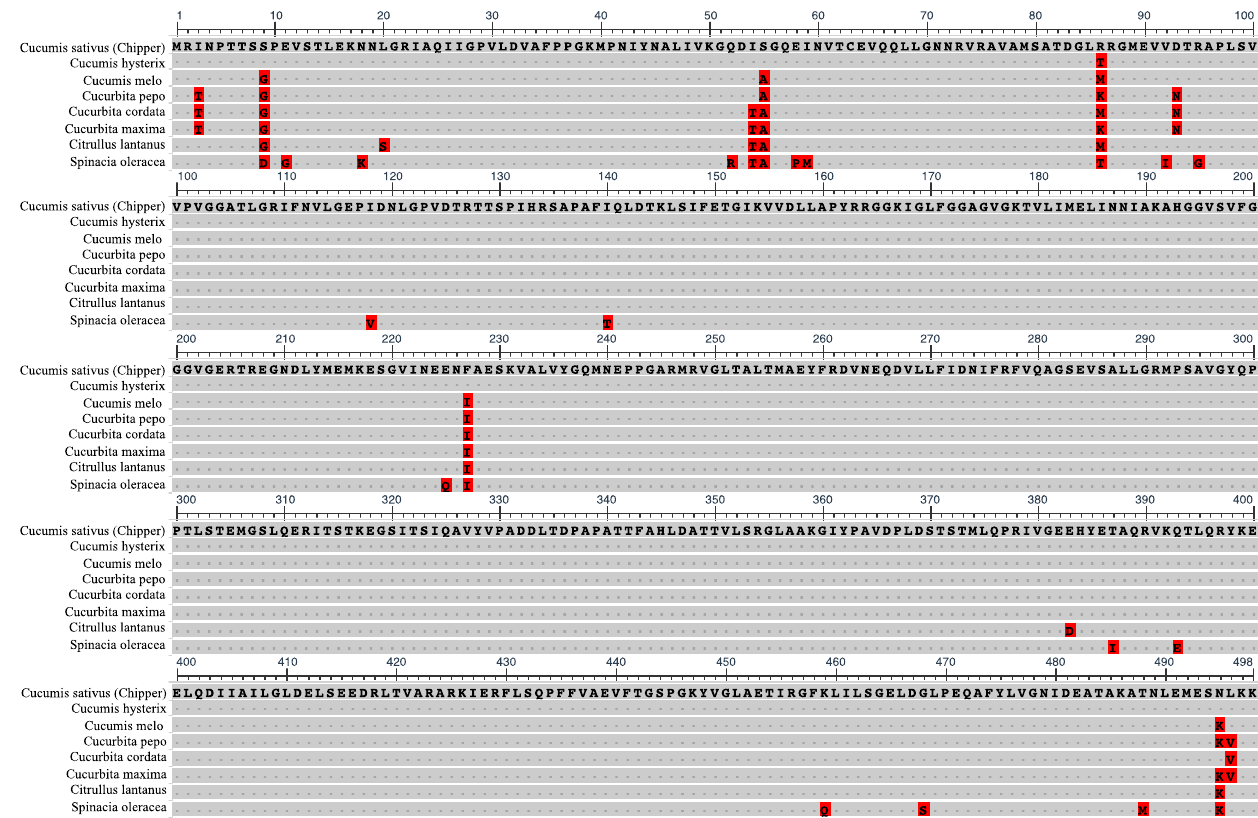
Figure 7. Alignment of the amino acid sequence of the ‘Chipper’ chloroplast F 1 F O -ATP synthase β -subunit gene with other plant species. Dots represent homology with ‘Chipper’ sequence. Highlighted amino acids indicate polymorphisms. Unique Chipper polymorphism is located at position 86.